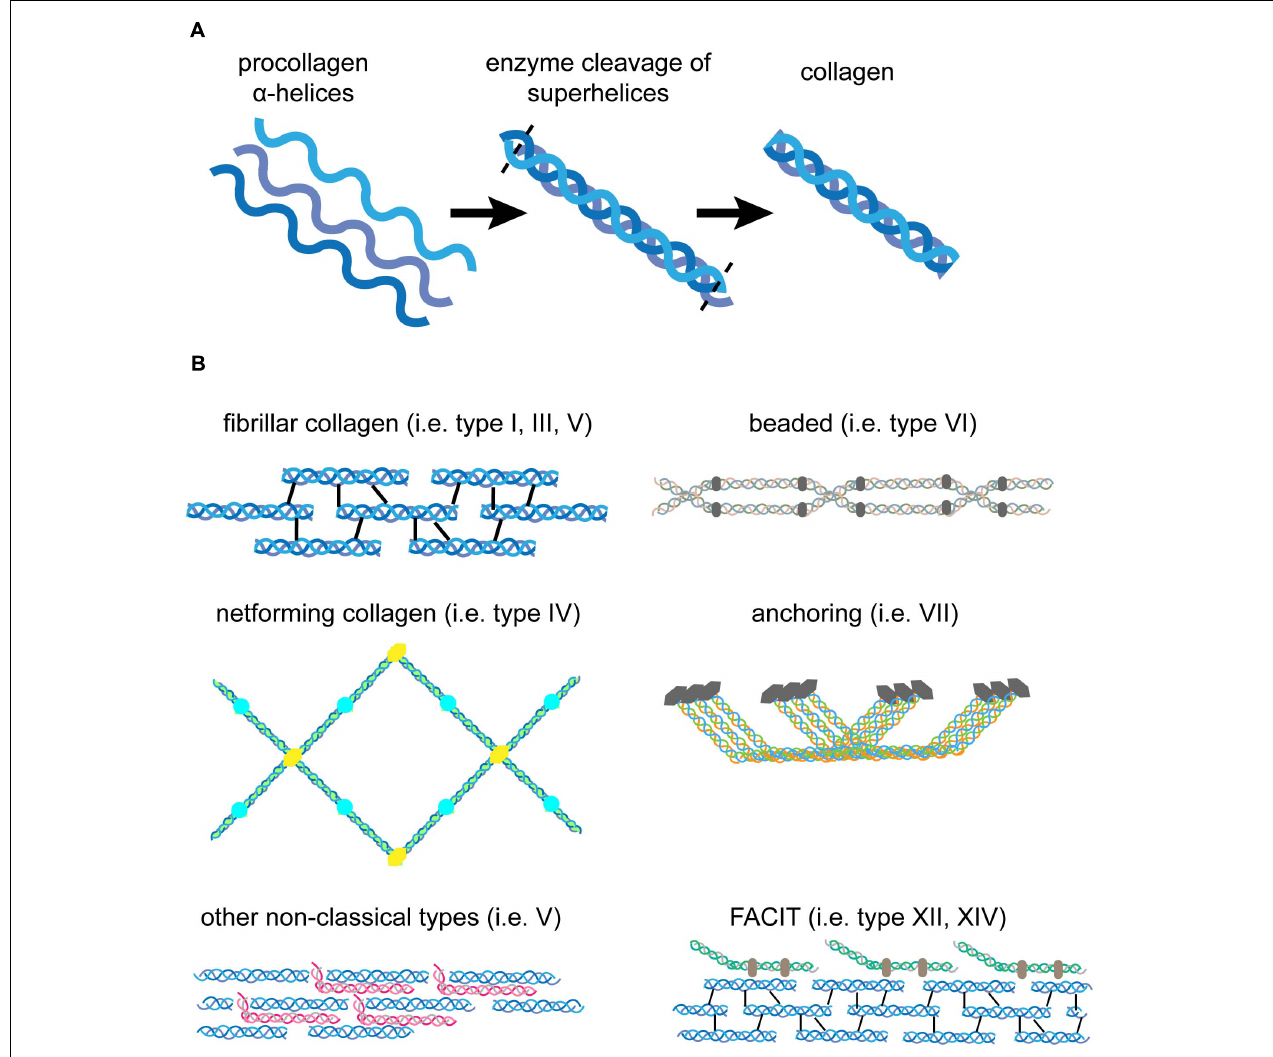
FIGURE 2 | Structure of pro-collagen and assembled collagen. (A) Three left-handed α -helices (left) form a right-handed collagen superhelix (middle) within collagen-producing cells. Once secreted to the extracellular space, enzymes cleave off the N- and C-terminal parts to form fully functional collagen (right). (B) Different forms of collagen assemble into diverse structures. Fibrillar collagen molecules assemble into collagen fibrils that are stabilized by crosslinking (type I, III, V). The net-forming collagen type IV can build a meshwork that is highly flexible compared to rigid fibrils. Non-classical collagens, such as type V and FACIT interact with collagen fibrils to enhance stability. Beaded collagen (type VI) links collagen type IV to collagen type I and III and increases tissue elasticity. Collagen type VII assembles into fibrils that anchor the BM to the papillary dermis and maintain tissue